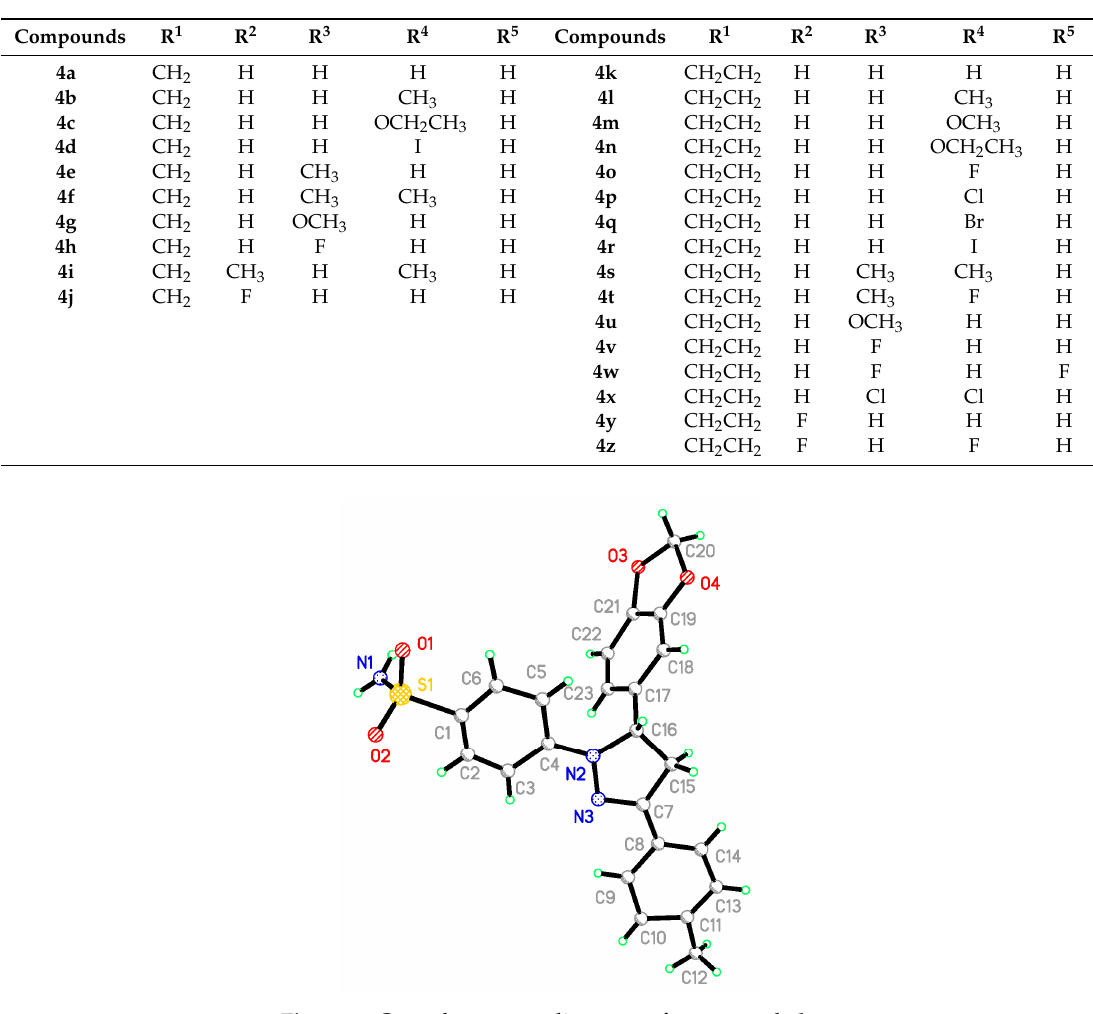
Table 1. Structures of compounds 4a – 4z .